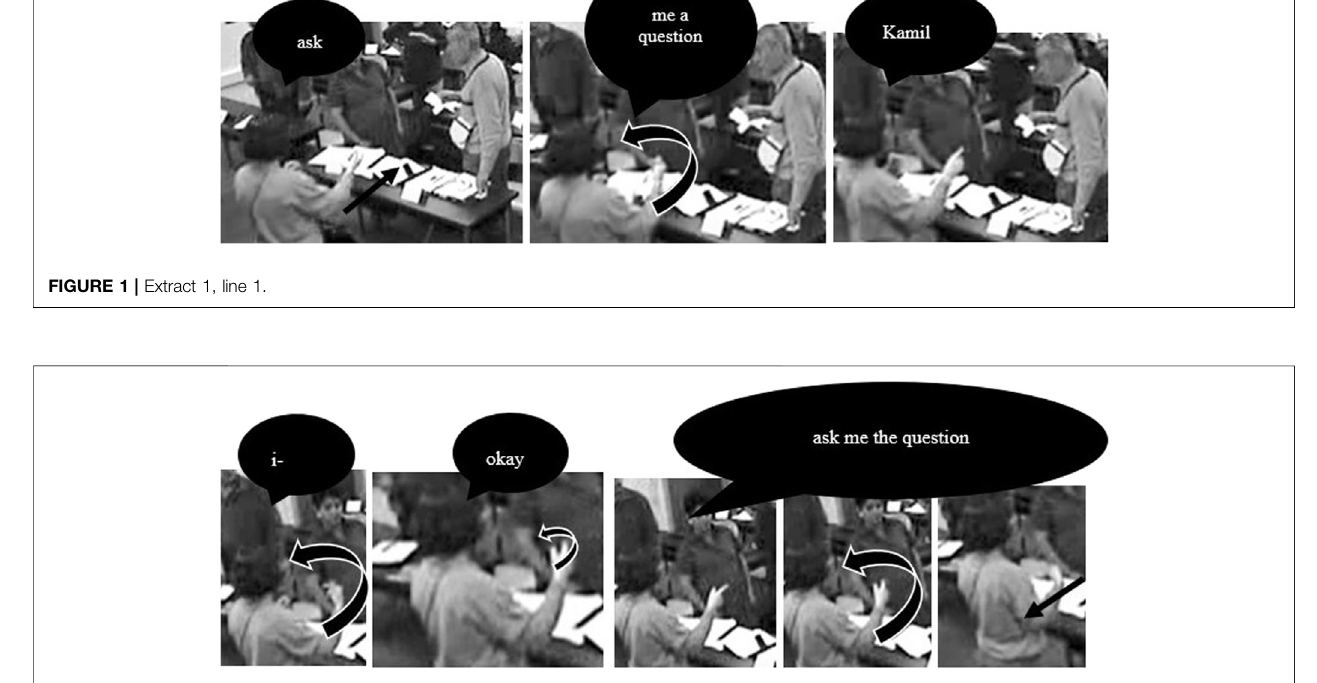
FIGURE 2 | Extract 1. line 2. Teacher